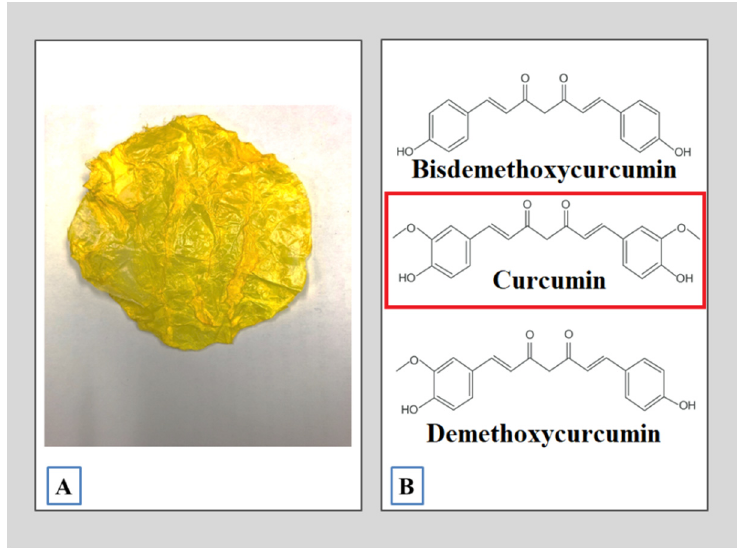
Figure 1. Curcuma longa L . ( A ) The curcuma leaf; ( B ) the main bioactive compounds present in CUR.